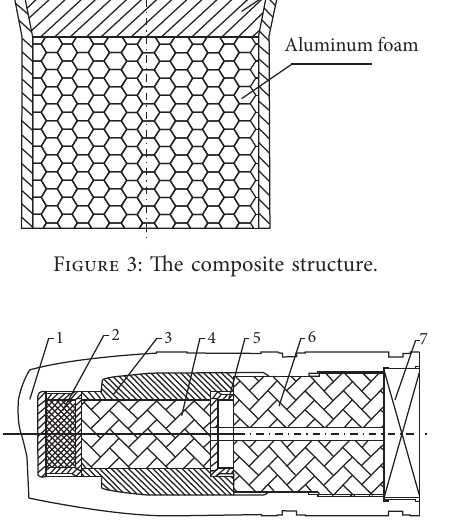
Figure 4: The structure of 125mm EPW: (1) mian body; (2) buffer No. 1; (3) collar; (4) acceleration sensor 1#; (5) buffer No. 2; (6) acceleration sensor 2#; (7) tail.